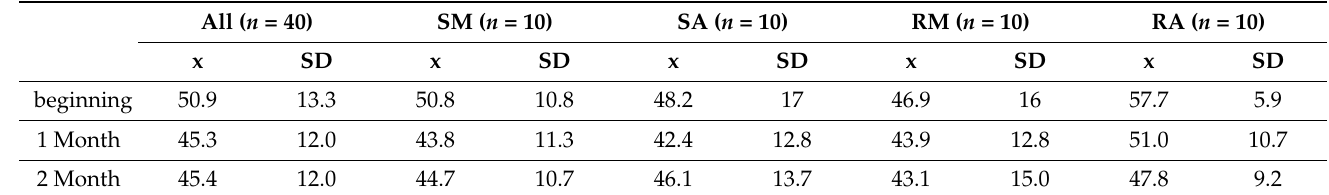
Table 5. ISQ values.